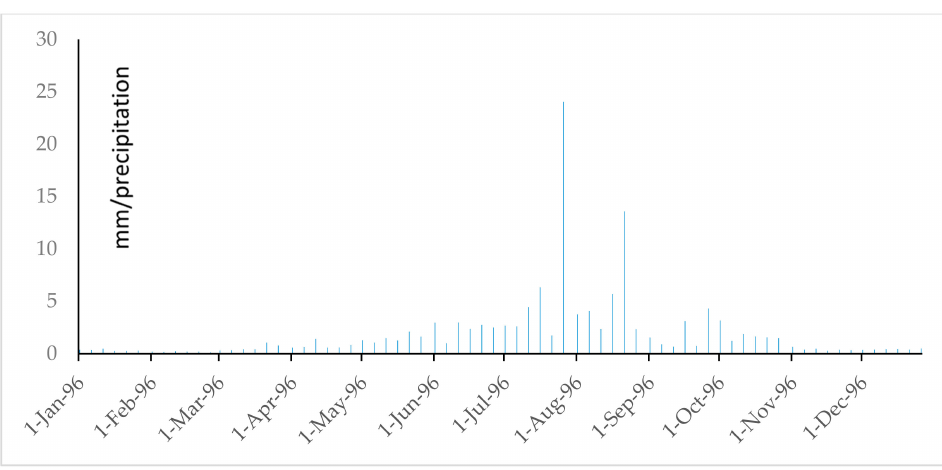
Figure A23. Precipitation of Denko County in 1995.